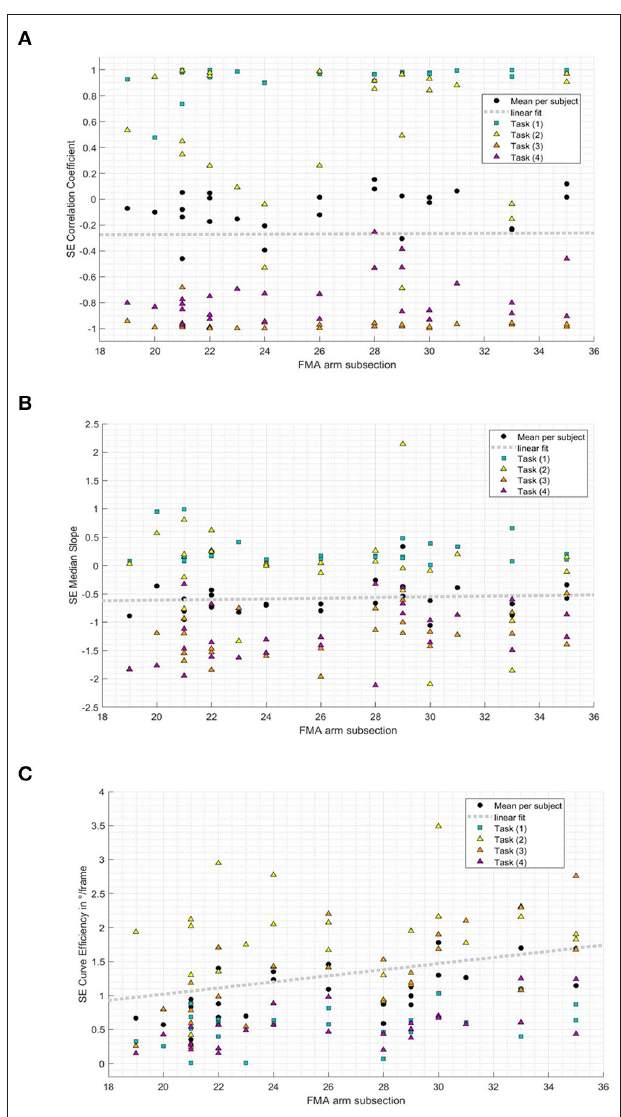
FIGURE 6 | Relation between shoulder–elbow coordination metrics and the Fugl–Meyer Motor Assessment of the Upper Extremity arm subsection (19-35/36) per subject and task. (A) Shoulder-elbow correlation coefficient per subject FMMA-UE arm subsection and task. (B) Shoulder-elbow median slope per subject FMMA-UE arm subsection and task. (C) Shoulder-elbow curve efficiency per subject FMMA-UE arm subsection and task.